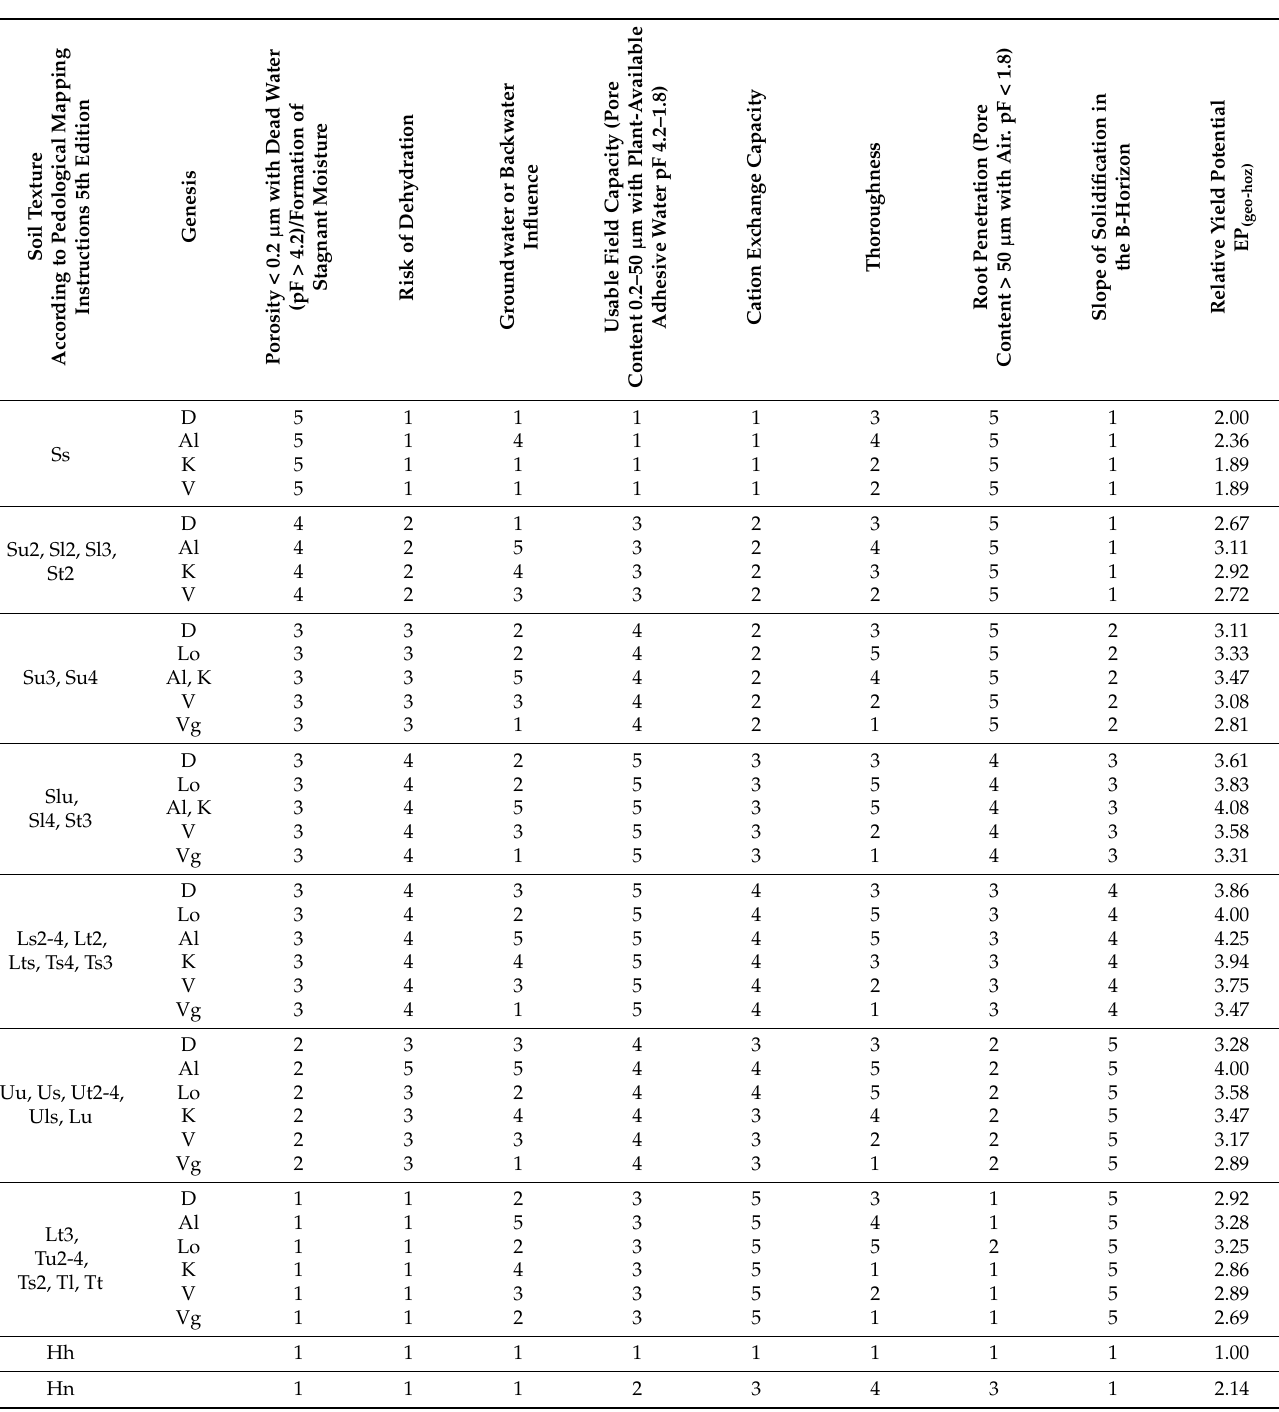
Table 7. Classification and scoring of soils according to pedogenesis and texture with regard to the influence on potential arable wood and grassland